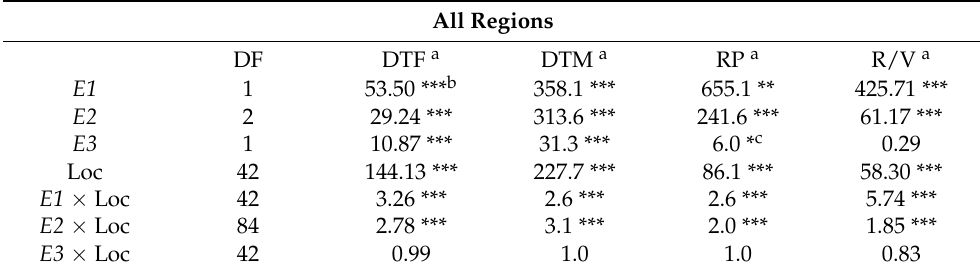
Table 2. Analysis of variance of E genes with days to flowering, days to maturity, reproductive period and R/V across all regions and in each